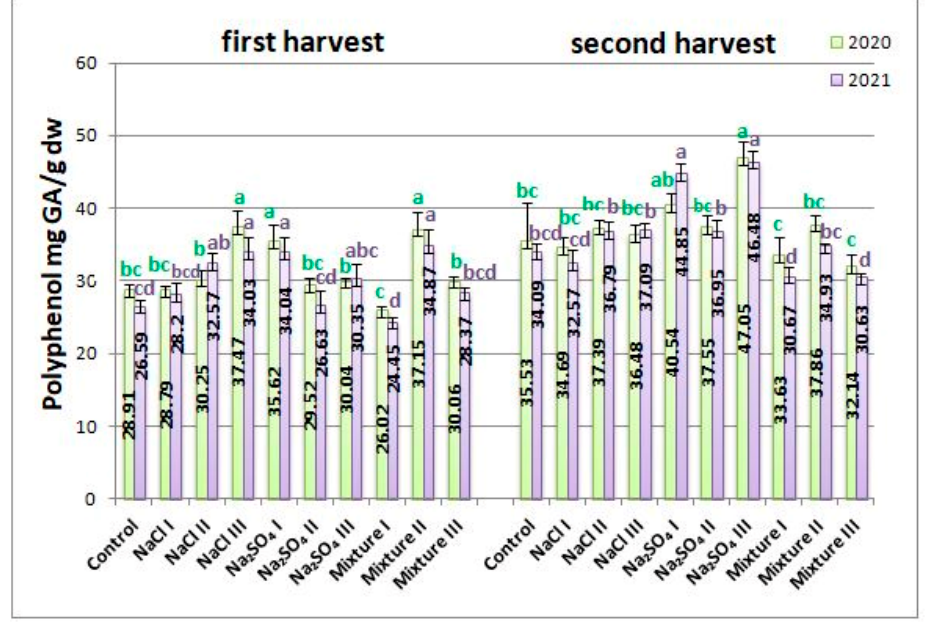
Figure 5. Average polyphenol content in Nepeta racemosa Lam. variants from 2020 and 2021, with significant differences at 0.05 level indicated with letters.